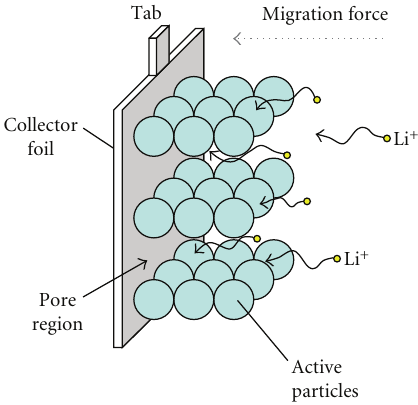
Figure 3: Illustration of a porous electrode geometry where lithium ions are